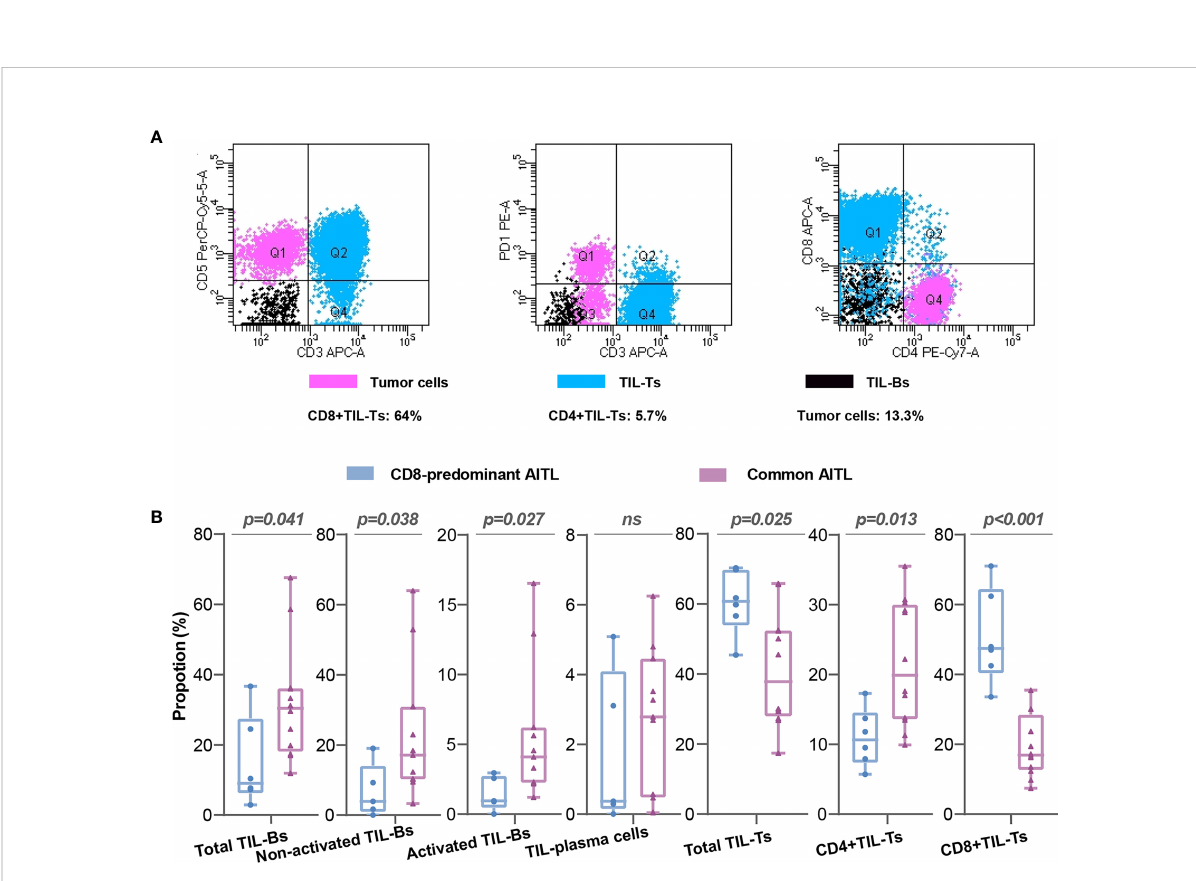
FIGURE 3 Flow cytometry analysis of CD8-predominant AITLs and matched common AITLs. Flow cytometry analysis of a typical case (C1) of CD8- predominant AITL (A) Comparisons of TIL subsets in fl ow cytometry analysis between CD8-predominant AITLs and matched common AITLs (B) . “ ns ” indicates “ no signi fi cance ”